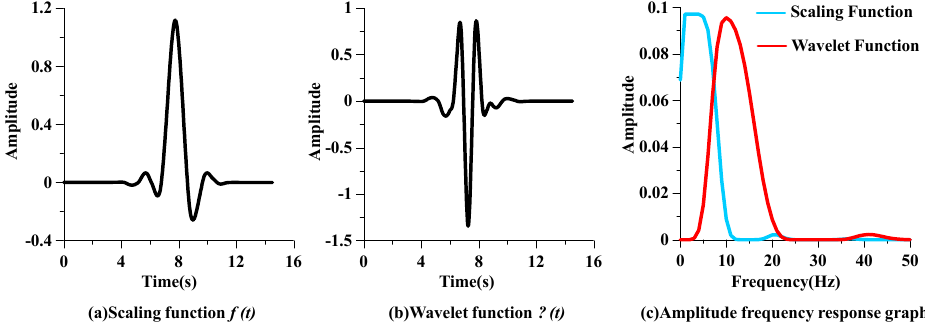
Figure 6. Sym8 scaling function and wavelet function with their amplitude frequency response.